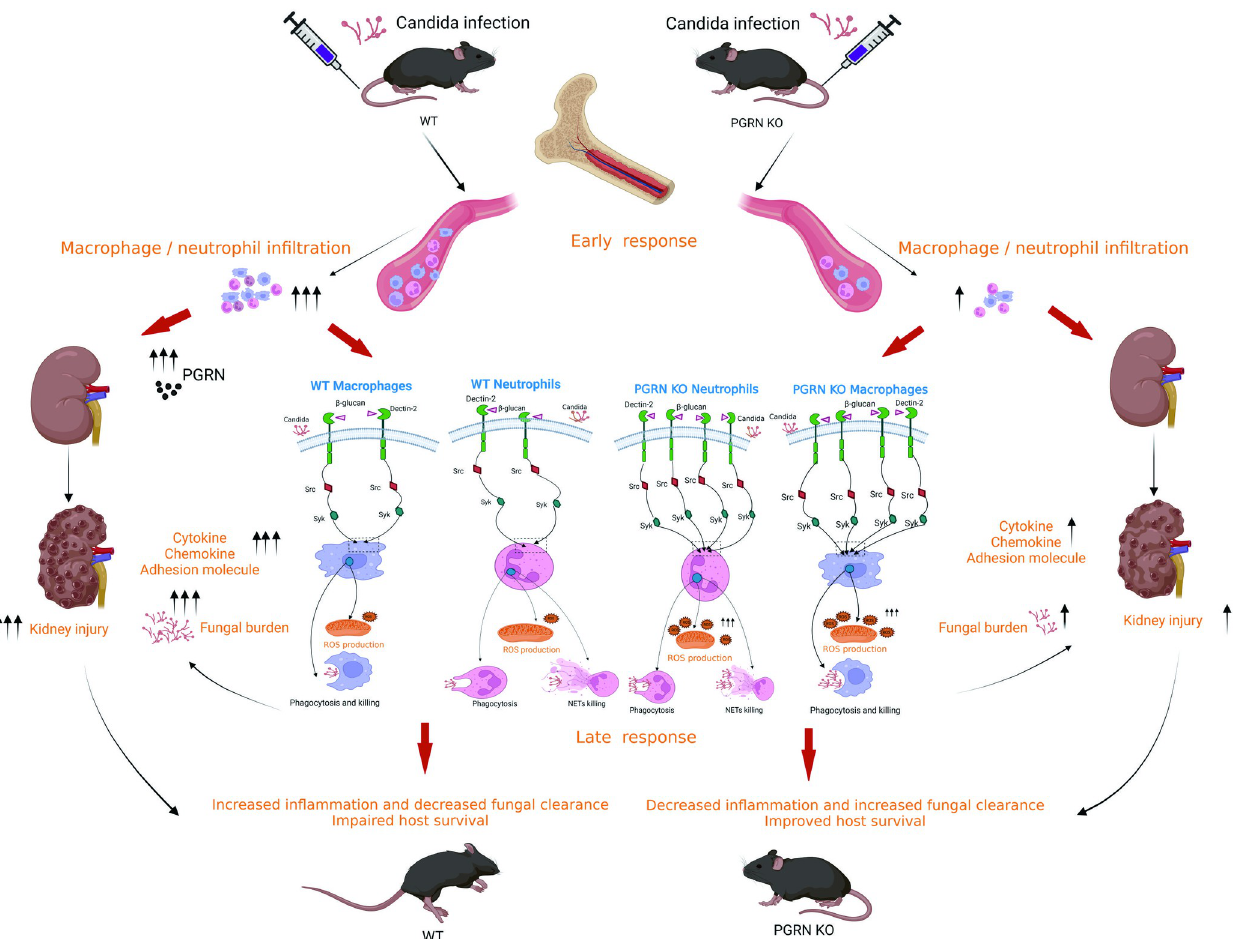
Fig 10. Proposed model of PGRN regulation of inflammatory reactions and antifungal immunity in response to C . albicans infection. C . albicans recognition induces PGRN production, which plays an important role in the immunopathology of invasive C . albicans infection. At an early phase of invasive C . albicans infection, PGRN loss does not affect fungal burden in the kidney, but it dampens acute inflammatory responses in the kidney involving the production of lower levels of inflammatory cytokine (IL-6) and chemokine (CXCL1 and CCL2), and the expression of reduced levels of adhesion molecule (ICAM-1 and P-Selectin), as well as the infiltrate of declined numbers of macrophage and neutrophil, supporting that PGRN participates in modulating an early harmful inflammatory response to C . albicans infection. At a later phase of invasive C . albicans infection, PGRN loss leads to lower fungal burden in the kidney, which is associated with increased antifungal immunity in PGRN-deficient macrophages and neutrophils. In the absence of PGRN, it can induce up-regulated expression of Dectin-2, and enhance phosphorylation of Src and Syk, as well as increase phagocytosis, reactive oxygen species (ROS) production, neutrophil extracellular traps (NETs) release, and fungal killing in macrophages or neutrophils, which limits fungal load and provides less inflammatory stimulus. Therefore, PGRN loss contributes to the protection against lethal C . albicans sepsis at two different but interconnected ways: the attenuated harmful host inflammatory response and the enhanced antifungal immunity that eliminates the C . albicans . These two processes regulate each other, which improves host survival in PGRN-deficient mice.